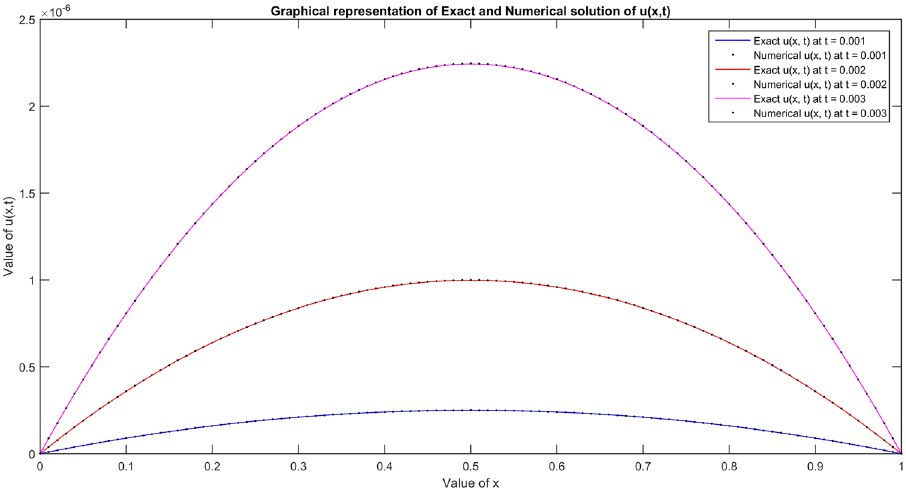
Figure 3: Comparison of results of ( ) u x t , at = t 0.001 , 0.002, and 0.003 with = N 101 , = α 0.008 , = β 0.008 , = t Δ 0.0001 , = τ 0.5 using Method I regarding Example 2.